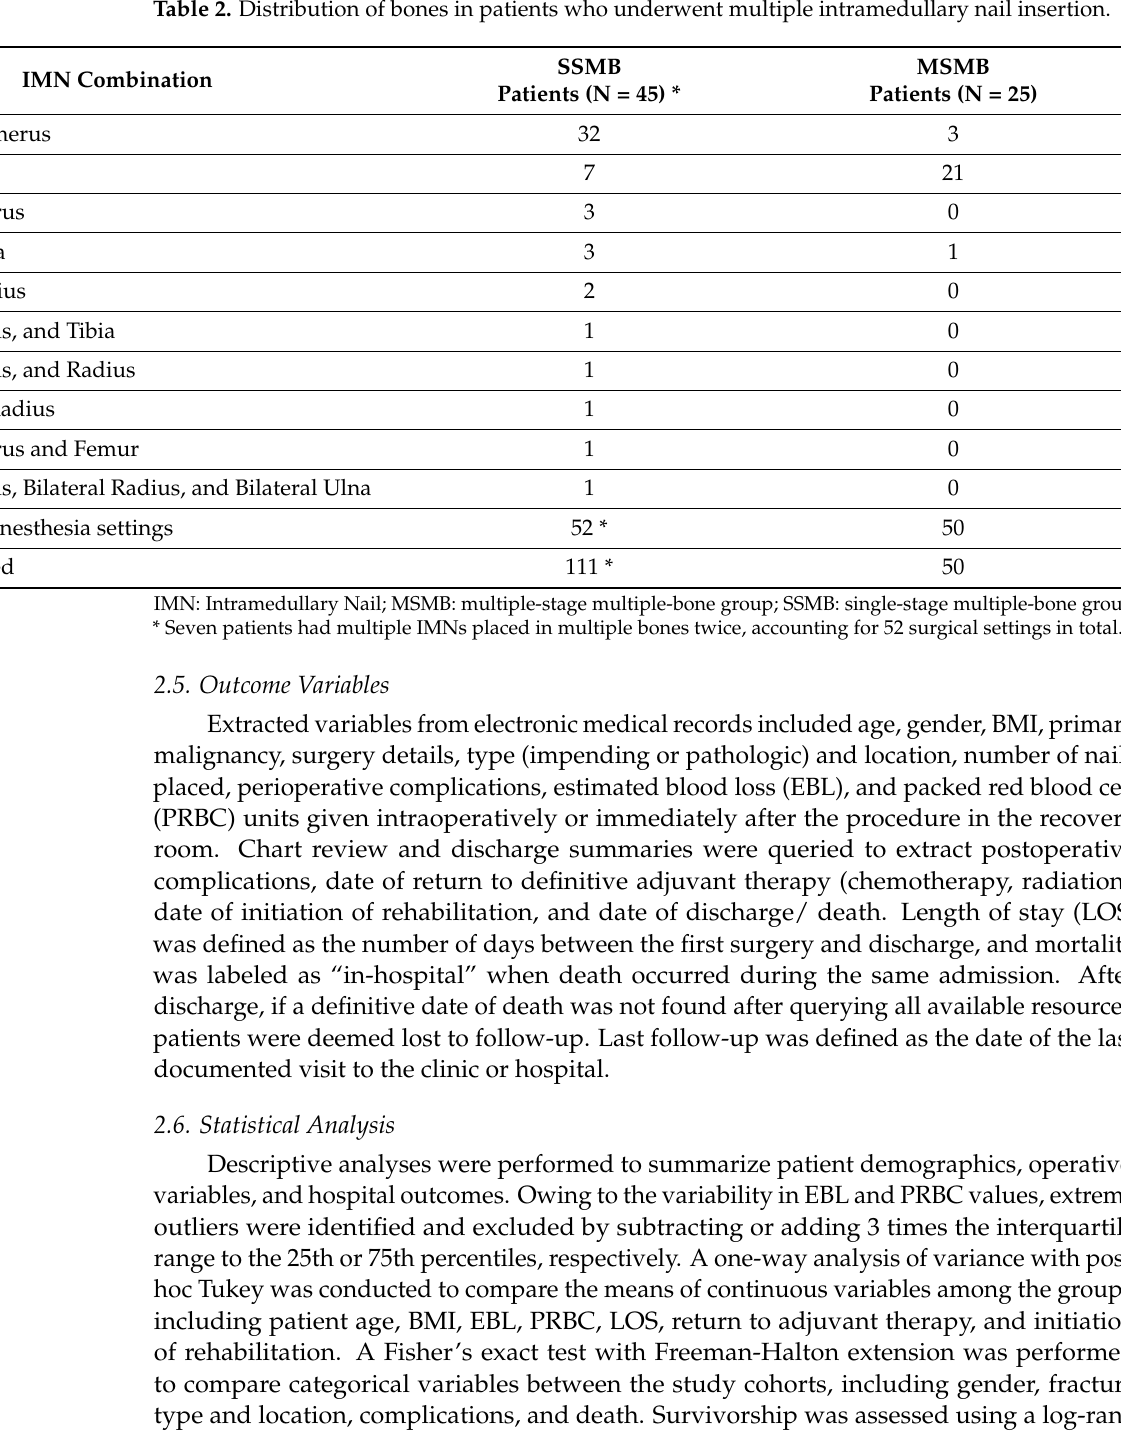
Table 2. Distribution of bones in patients who underwent multiple intramedullary nail